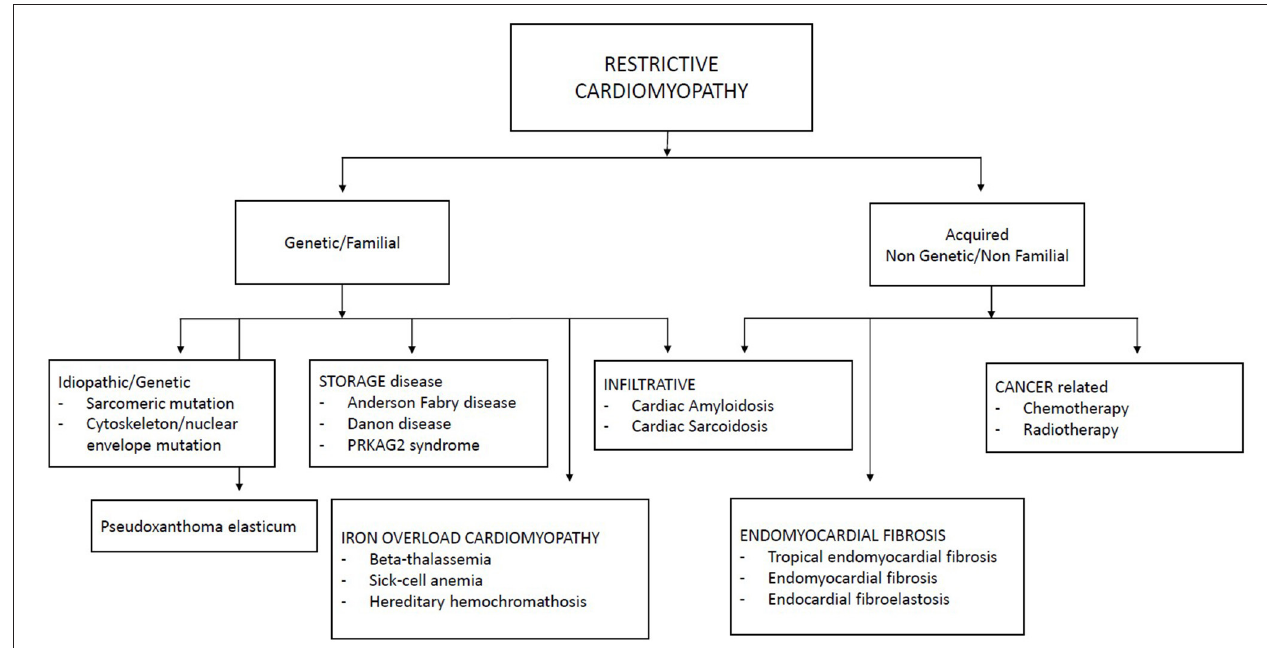
FIGURE 1 | Classification of restrictive